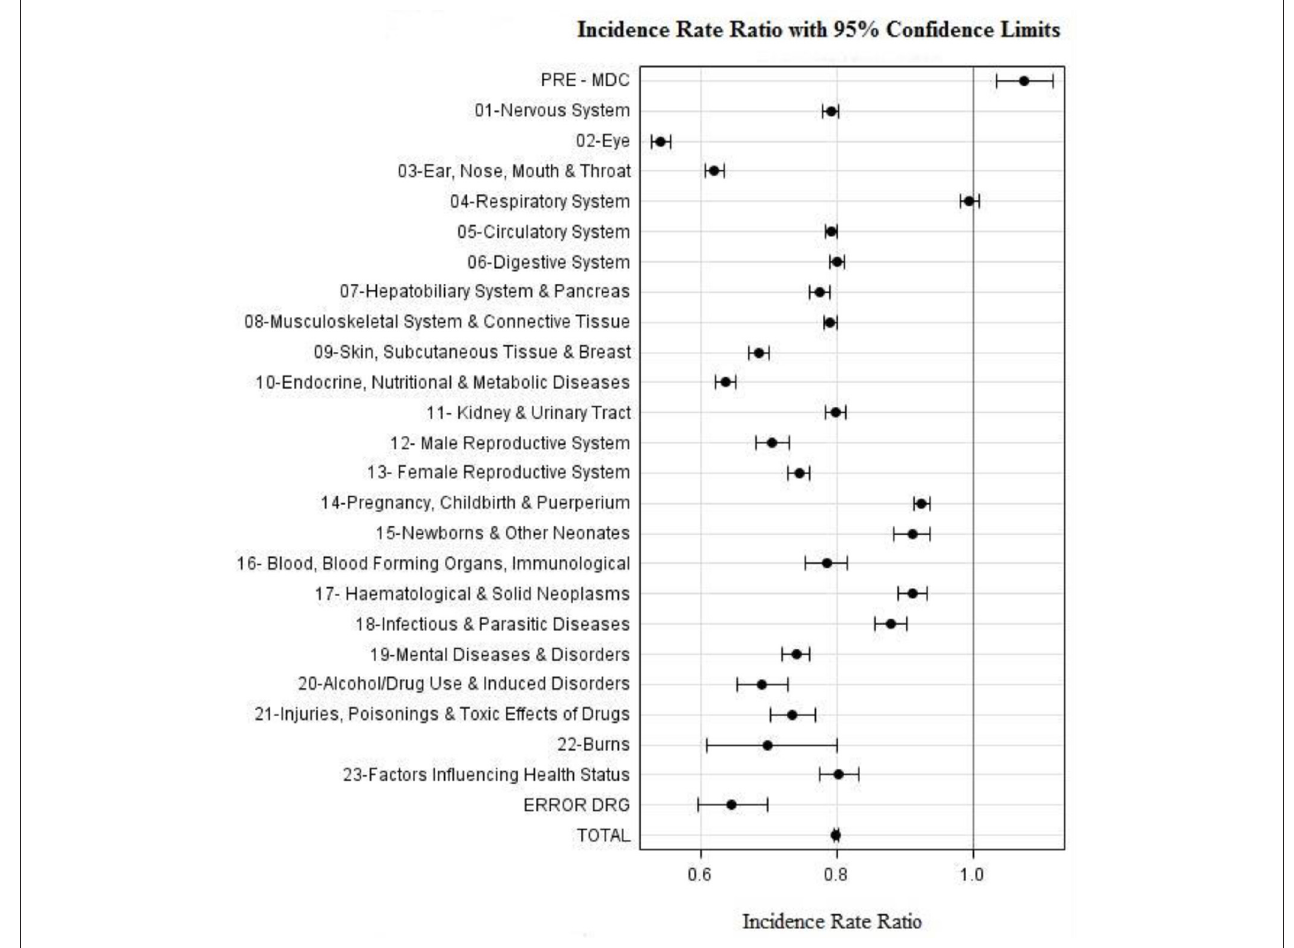
FIGURE 2 | Incidence Rate Ratio per MDC during 2020 as compared to period